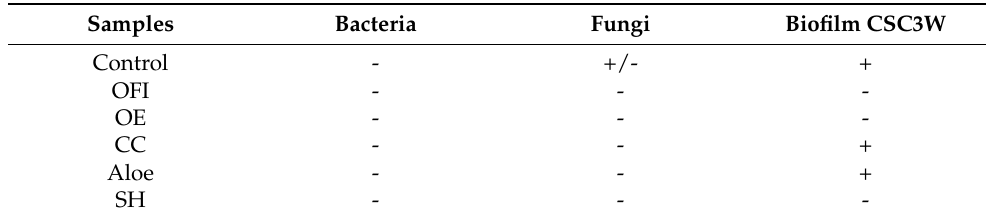
Table 2. Response of inoculation on mortar and bio-mortars after 3 months of testing. (-) no growth; (+/-) little growth; (+) full